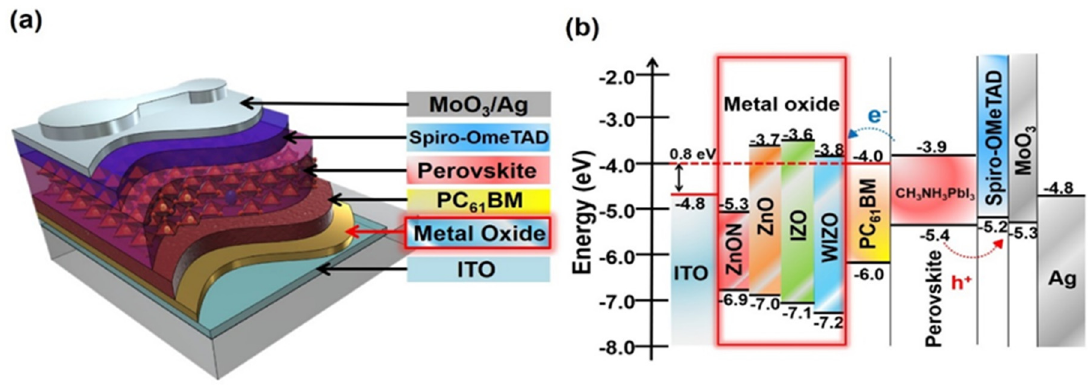
Figure 1. Schematic diagrams. ( a ) Device architecture of N–I–P perovskite cells with various metal oxide layers and ( b ) corresponding energy band diagram (all energies are relative to the vacuum level).